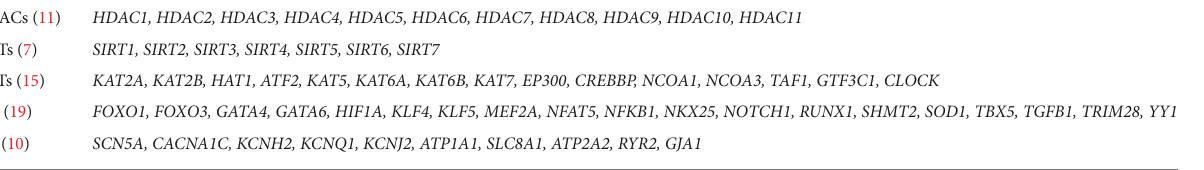
TABLE 1 Genes considered in the